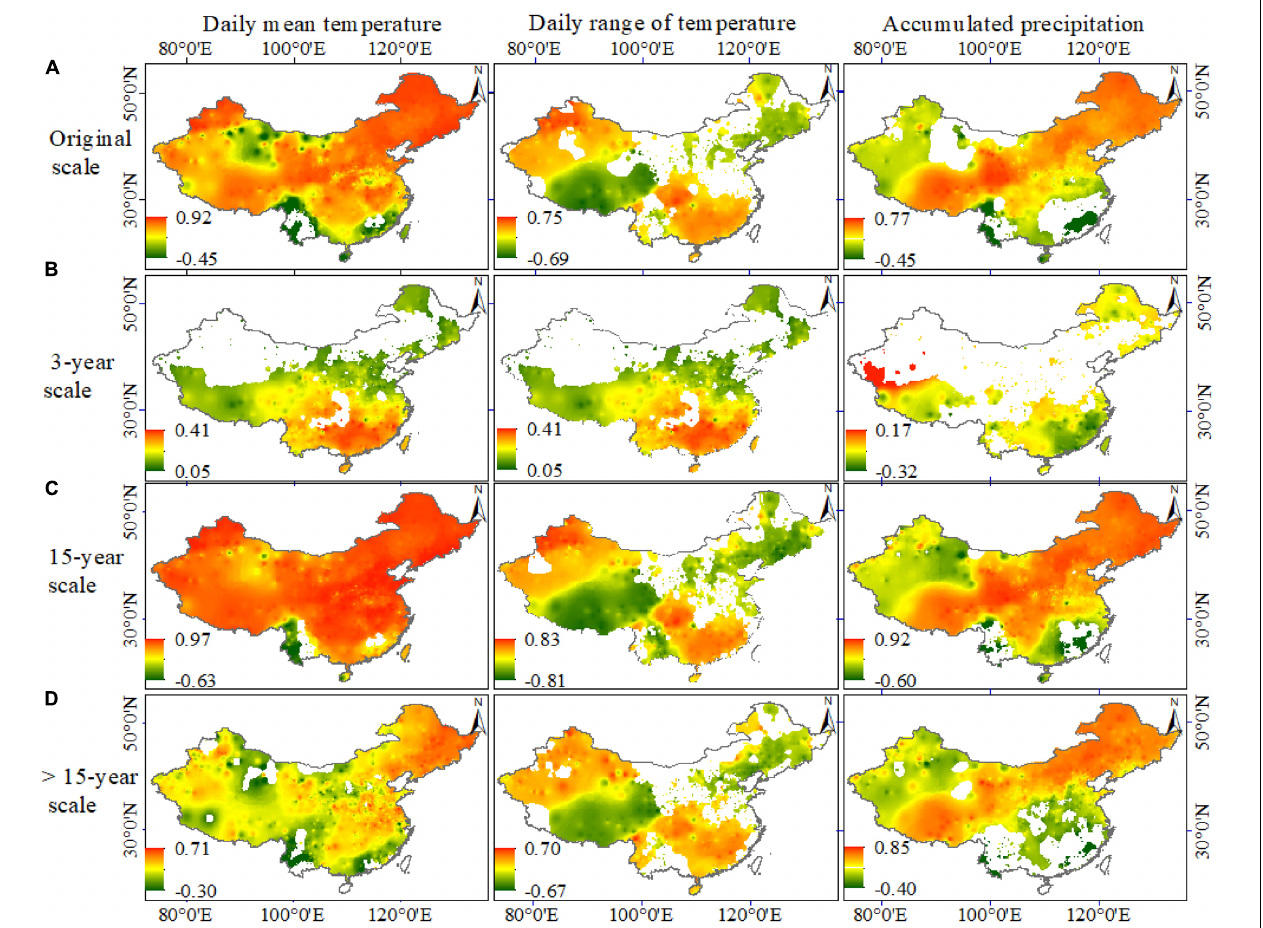
FIGURE 2 | Spatial distribution of correlation coefficients between NDVI and climatic factors (daily mean temperature, daily range of temperature, and accumulated precipitation) during 1982–2013 at different temporal scales, including (A) original scale, (B) 3-year scale, (C) 15-year scale, and (D) > 15-year scale. NDVI, normalized difference vegetation